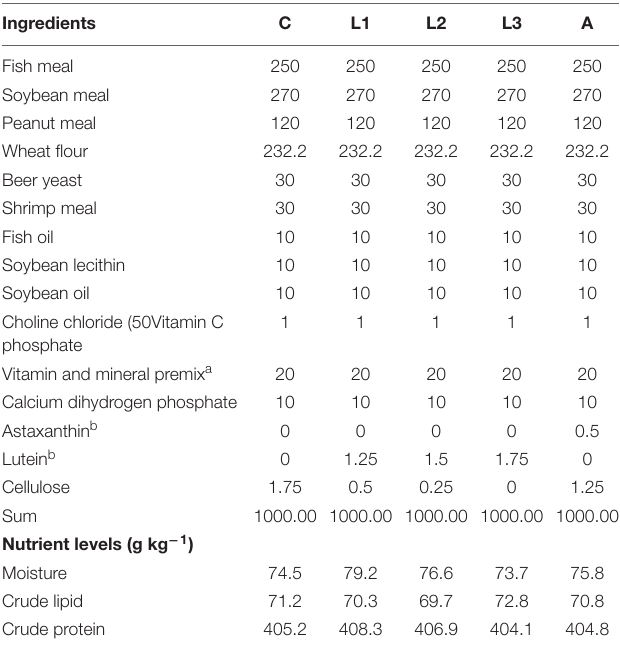
TABLE 1 | Ingredients and proximate composition of five experiment diets (g kg − 1 diets).